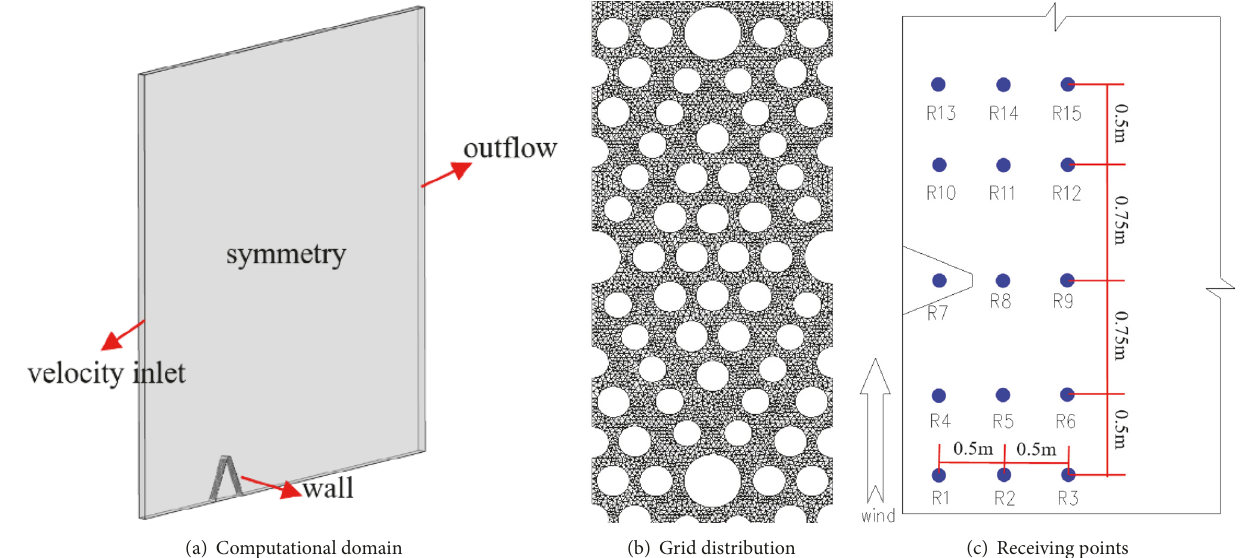
Figure 8: Computational domain, grid distribution, and sound pressure receiving points’ diagrammatic sketch.